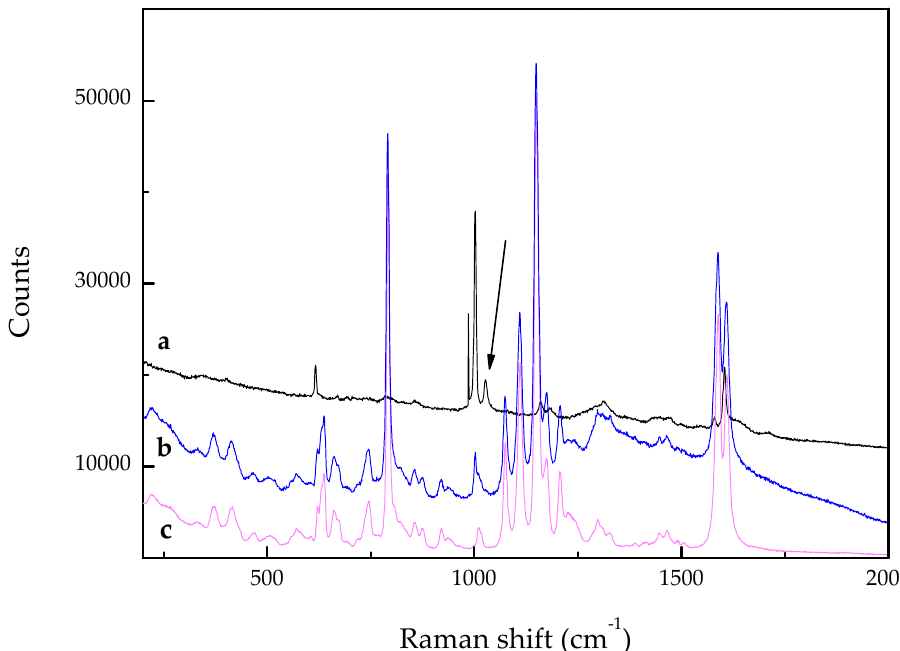
Figure 6. Raman spectra between 200 and 2500 cm − 1 of: ( a ) mG20; ( b ) Top surface of L20; ( c ) L0. The arrow indicates the band at 1030 cm − 1.